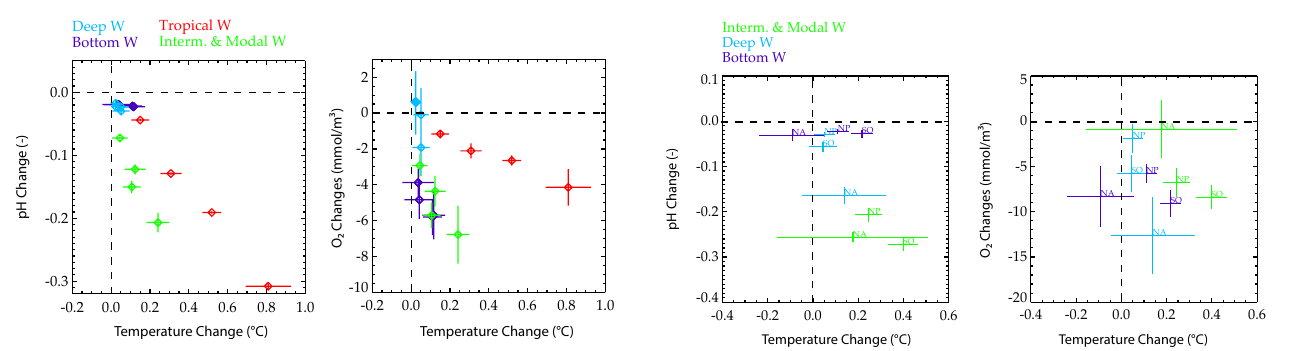
Fig. 13. Relation between model-mean changes in pH (pH unit), dissolved O 2 (mmolm − 3 ) and model-mean temperature change ( ◦ C), in three distinct global water masses (modal and intermedi- ate water mass, deep water mass and bottom water mass), for three different basins (North Atlantic, North Pacific and Southern Ocean) and for RCP8.5. For a definition of the different water masses, please see Sect. 2.3. Inter-model standard deviations are also in-